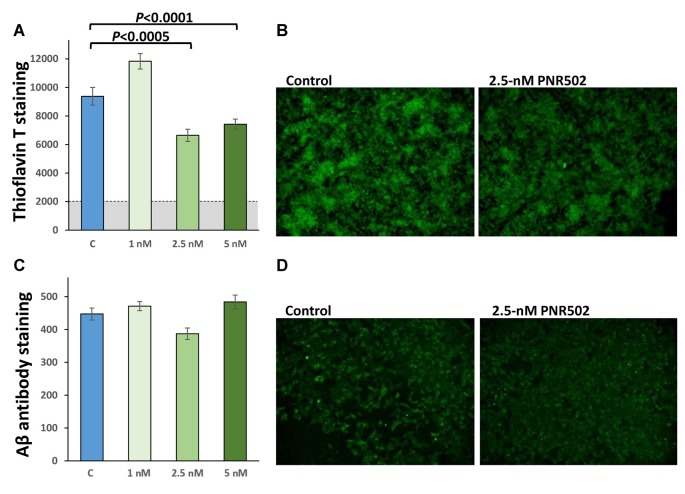
PNR502 reduces amyloid aggregation and shifts Aβ signal from punctate foci to diffuse background. SY5Y-APPSw cells were treated 48 h with the indicated concentrations of PNR502, and then fixed and stained in parallel with Thioflavin-T (total amyloid, A,B) or with antibody specific for Aβ1–17 (AbCam, ab11132; C,D). (A,C) Quantitations compared to six independent cultures per group, with P-values obtained from single-tailed t-tests appropriate when the direction of change is known.